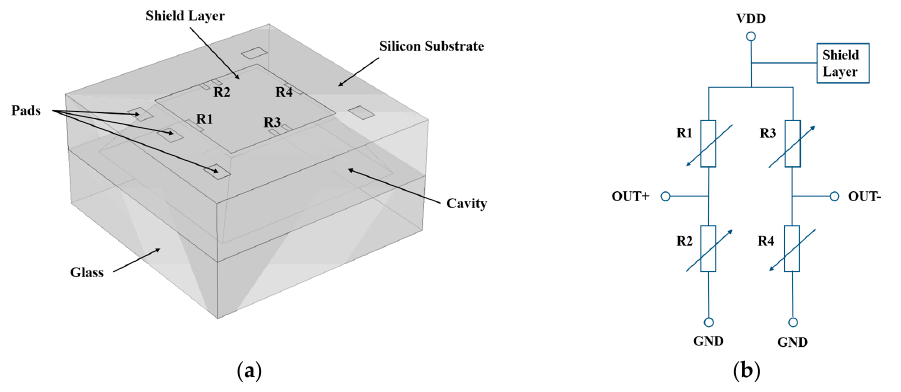
Figure 1. ( a ) Structure of the designed pressure sensor with a shield layer. ( b ) Equivalent circuit of the pressure sensor with a shield layer.